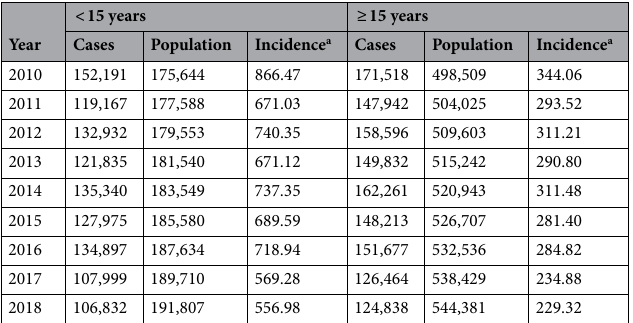
Table 1. Annual Incidence of common colds stratified by age groups in Bhutan, 2010–2018. a Incidence per 1000